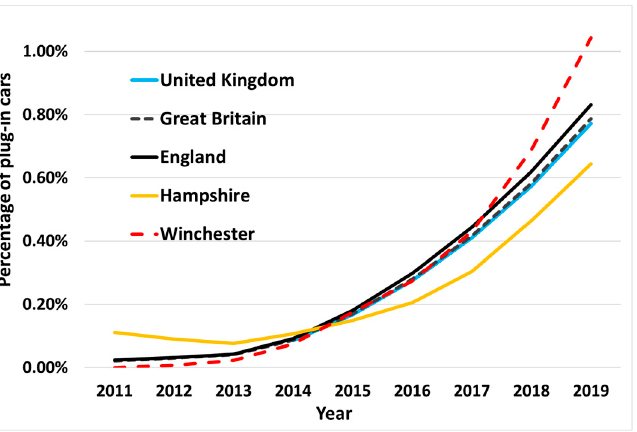
Figure 1. Growth from 2011–2019 in plug-in vehicle registration across the UK, Hampshire and Winchester, adopted from [8].